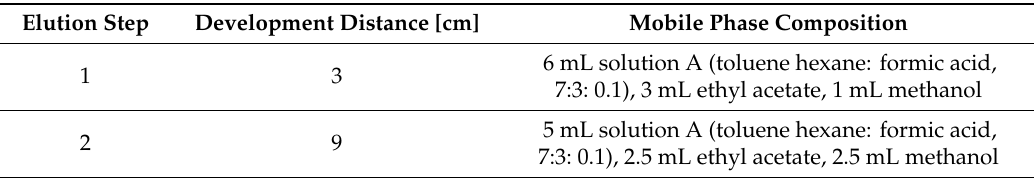
Figure 6. Fragments of corolla petals L. album subsp. album imaged by a fluorescence microscope. ( a , b ) Light blue autofluorescence of phenolic acids ( a ) in epidermis cells in the cross section of the corolla tube, ( b ) in epidermis cells and capitate trichomes. ( c – l ) Yellowish secondary fluorescence of flavonoids observed after the application of aluminum trichloride under the Cy 5 filter. ( c – e ) Capitate trichomes containing flavonoids. ( f , g ) Different-length conical trichomes visible on the adaxial surface of the corolla tube with flavonoids in the apical part. ( h ) Non-glandular trichomes from the upper lip: flavonoid fluorescence in the cell walls. ( i , j ) Papillae on the upper lip containing flavonoids. ( k , l ) Epidermis cells from the upper lip with flavonoid content. Abbreviation: Ad adaxial epidermis, Ab abaxial epidermis. Scale bars: 100 µm ( g , h ), 50 µm ( a ), 30 µm ( b , c , f , k ), 20 µm ( d , e , l ), 10 µm ( i , j ). Table 2. Multiple gradient development program in the analysis of flavonoids.